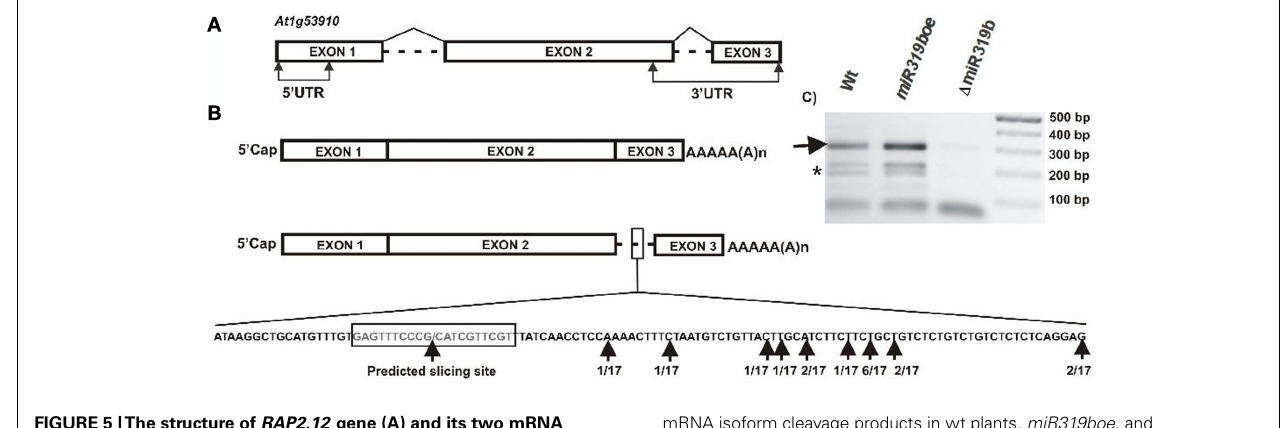
FIGURE 5 |The structure of RAP2.12 gene (A) and its two mRNA isoforms (B). The predicted slicing site within intron-retaining mRNA isoform is marked and enlarged. Black arrows point to predicted slicing site and identified products of 5 (cid:3) -RACE carried out for RAP2.12 slicing products. (C) The agarose gel showing the 3 (cid:3) -RAP2.12 intron-containing